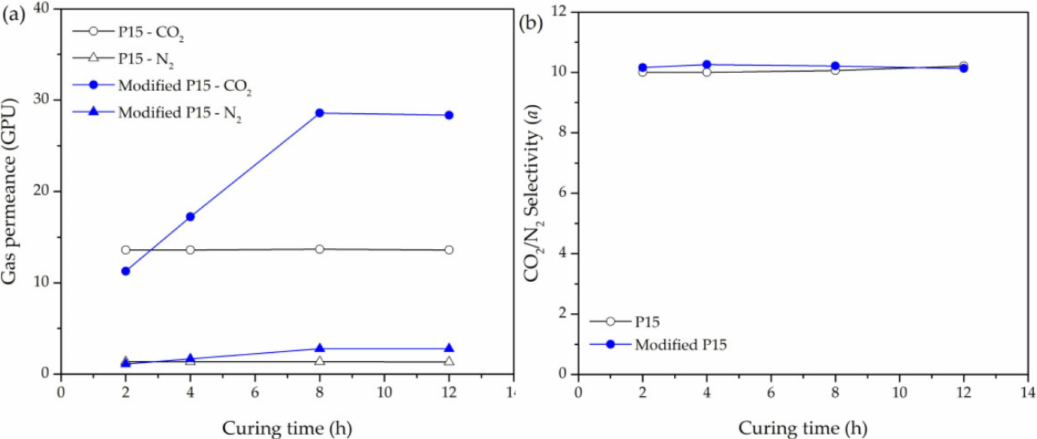
Figure 9. ( a ) The gas permeance and ( b ) ideal selectivity for CO 2 /N 2 at 25 ◦ C for P15 and the modified P15 membrane as a function of curing